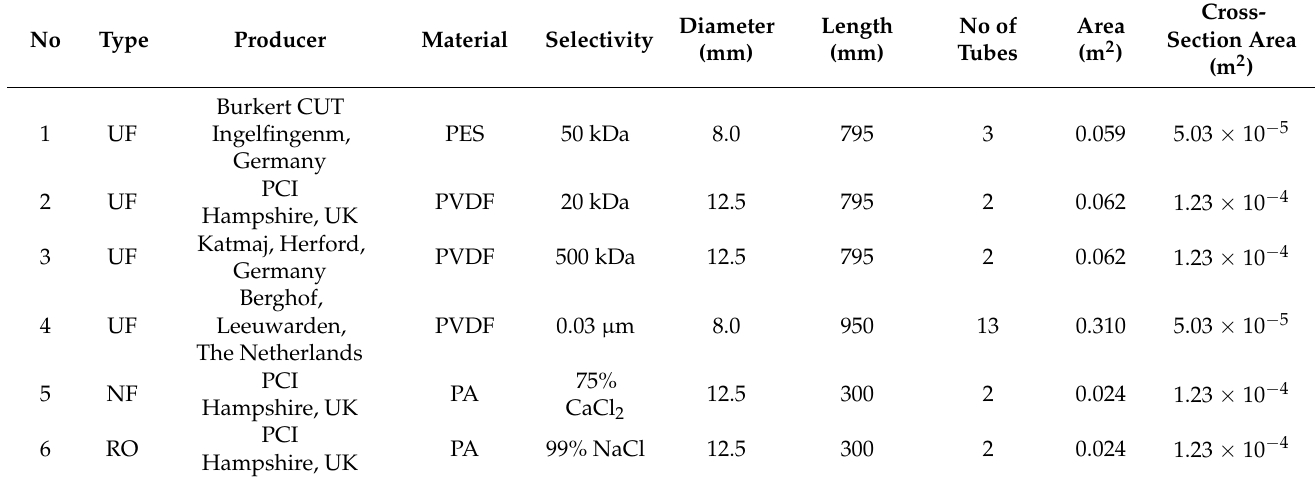
Table 3. The parameters of the membrane modules used during this research.